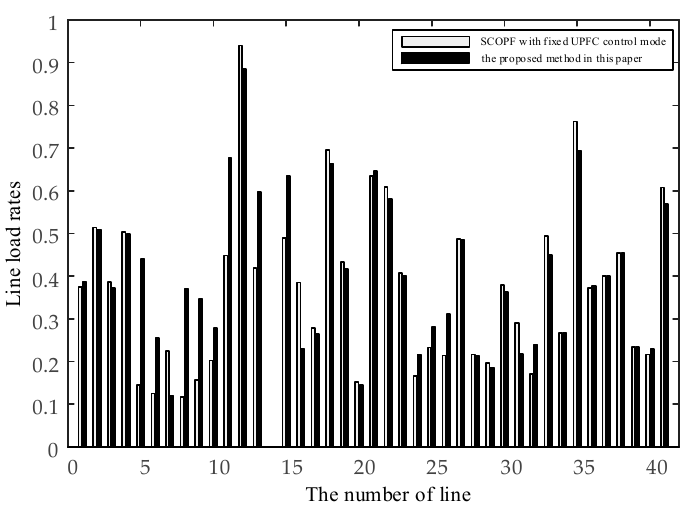
Figure 9. The comparison of line load rate under the failure of lines 9–10.